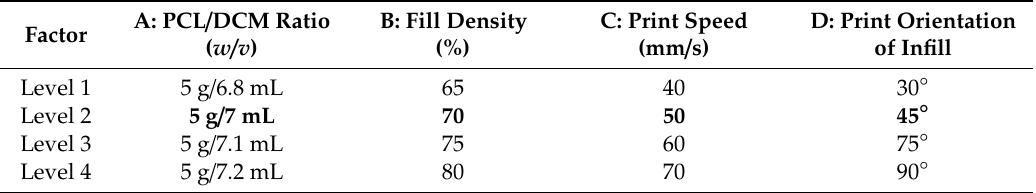
Table 1. Parameters used for the 3D printing